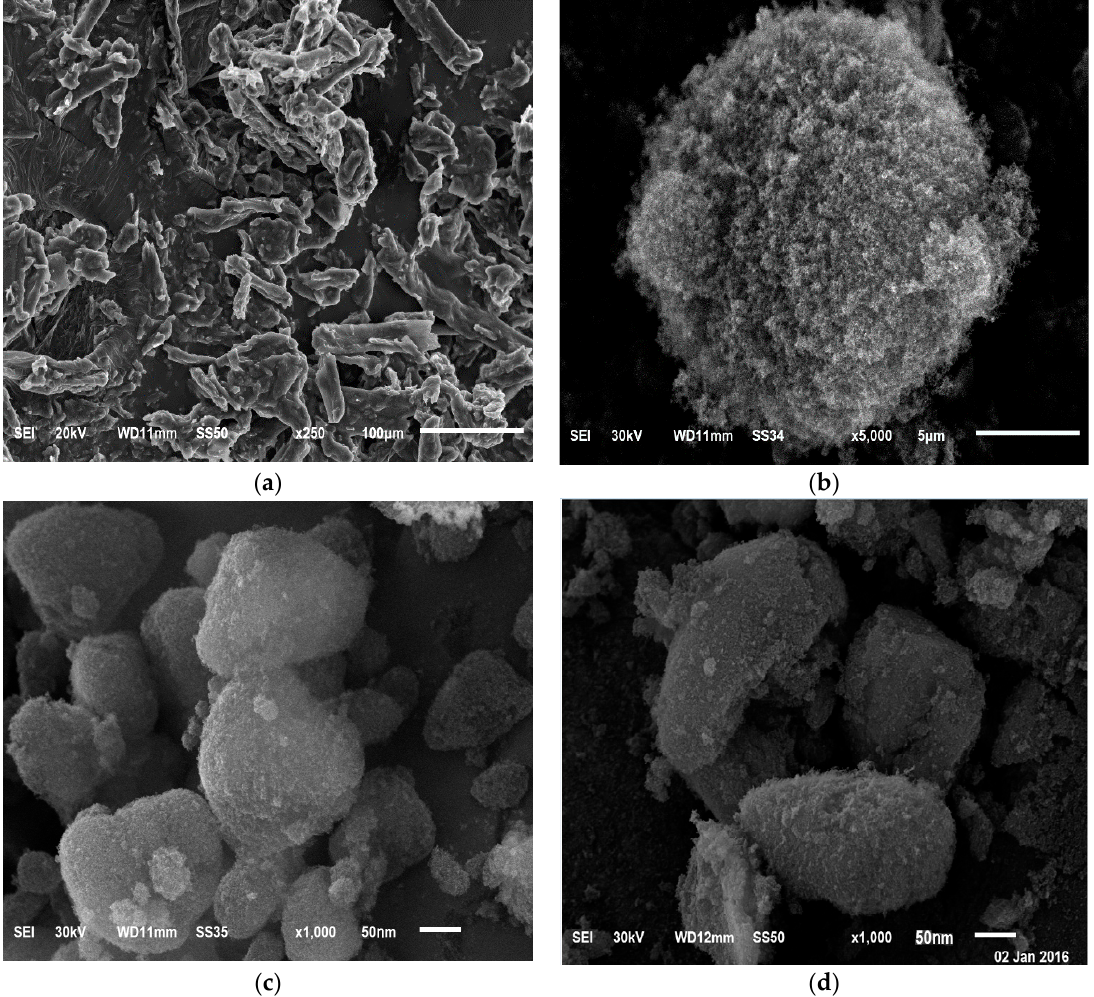
Figure 7. SEM photograph of pure ( a ) OLM; ( b ) Aerosil 200; ( c ) S-SNEDDS F3; ( d ) S-SNEDDS F4.